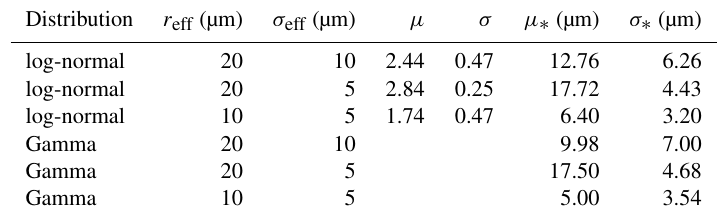
Table 4. Table of sensitivity tests for the theoretical distribution assumption, effective radius r eff and effective standard deviation σ eff of the cloud droplet size distribution; µ and σ are the mean and standard deviation of a normal distribution, corresponding to the log-normal distri- bution, numerically calculated from r eff and σ eff , and µ ∗ and σ ∗ are the actual mean and standard deviation of the distribution (numerically calculated).